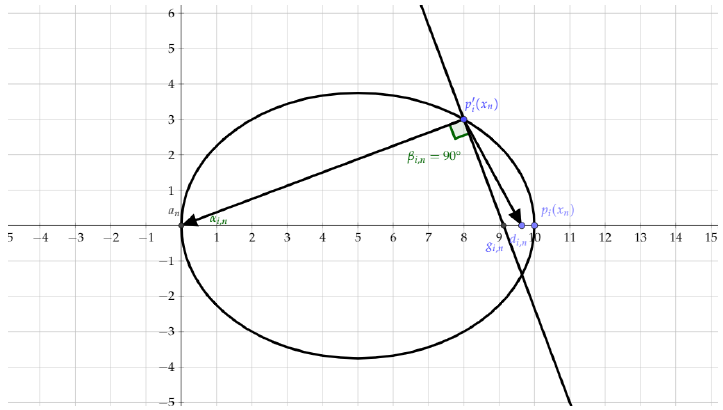
Figure 1. Section of the ellipsoid B i , n